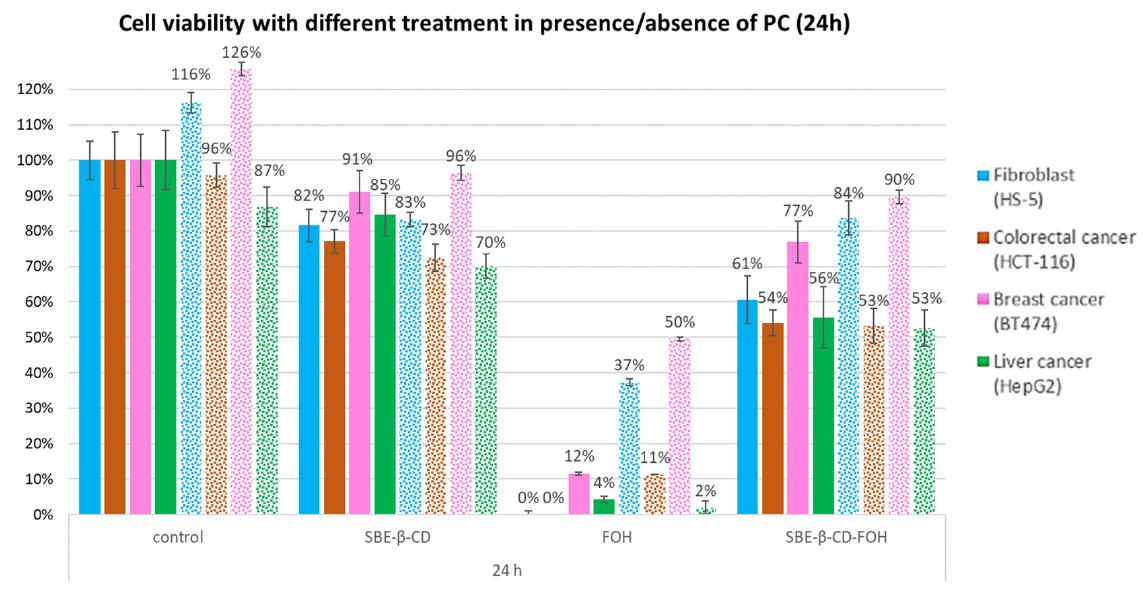
Figure 6. Cell viability results for each cell line treated for 24 h in absence (filled columns) or presence (dotted columns) of PC.